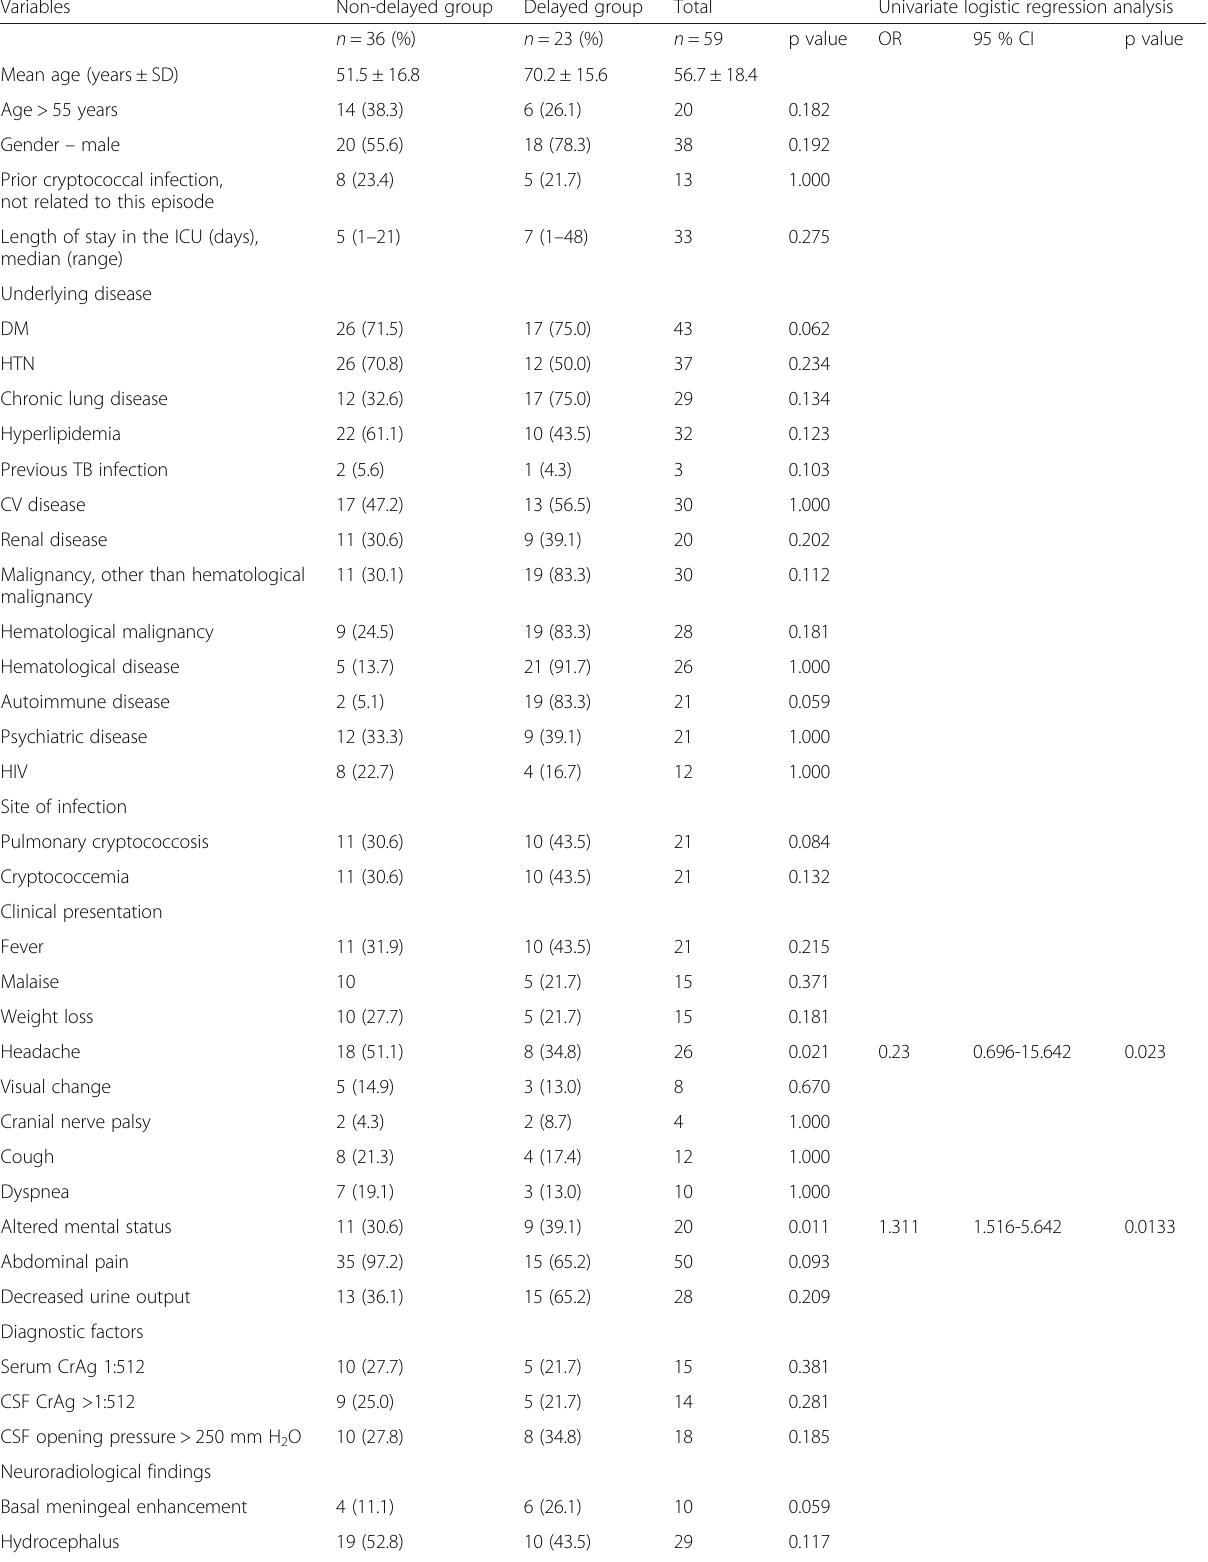
Table 3 Comparison of clinical features, laboratory findings, and outcomes between delayed and non-delayed groups of CM patients